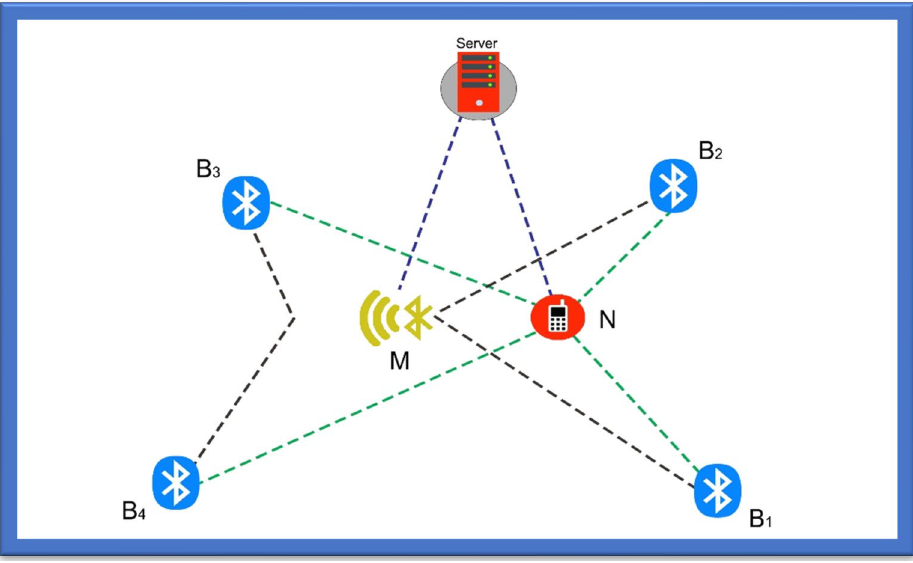
Figure 2. Bluetooth Triangulation.